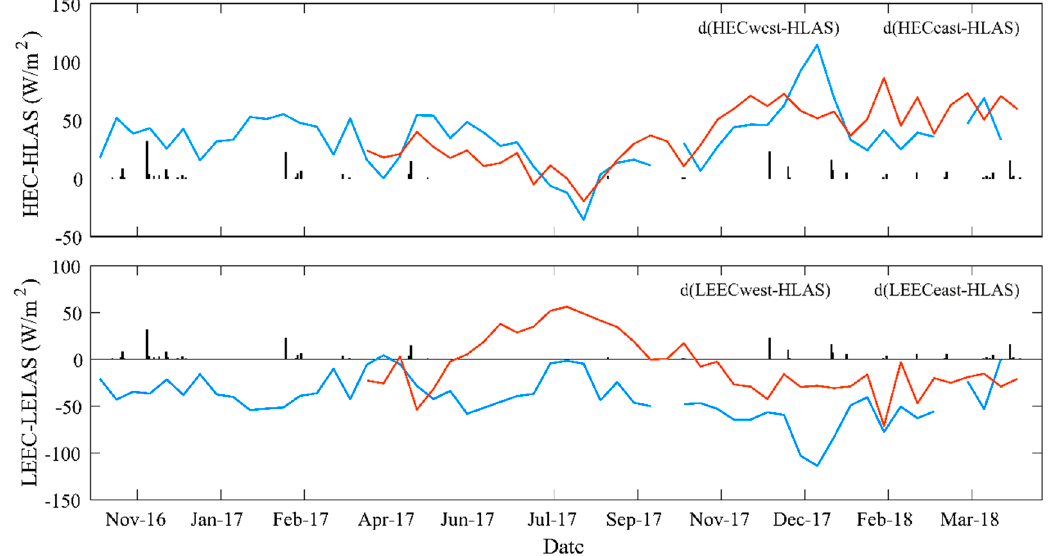
Figure 5. 10-day di ff erences between scintillometer and eddy covariance Figure 5. 10-day differences between scintillometer and eddy covariance measurements.